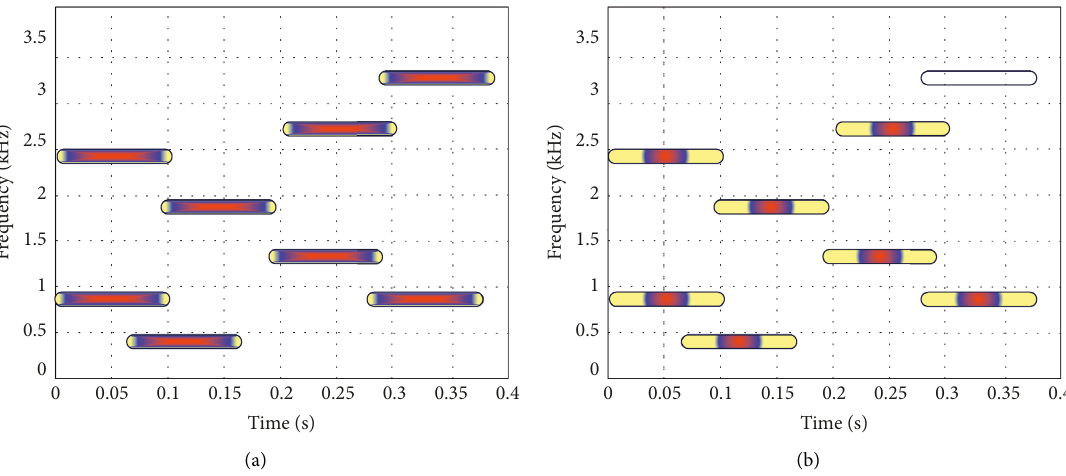
Figure 5: Two commonly used linear transformations. (a) Gabor transfer and (b) wavelet